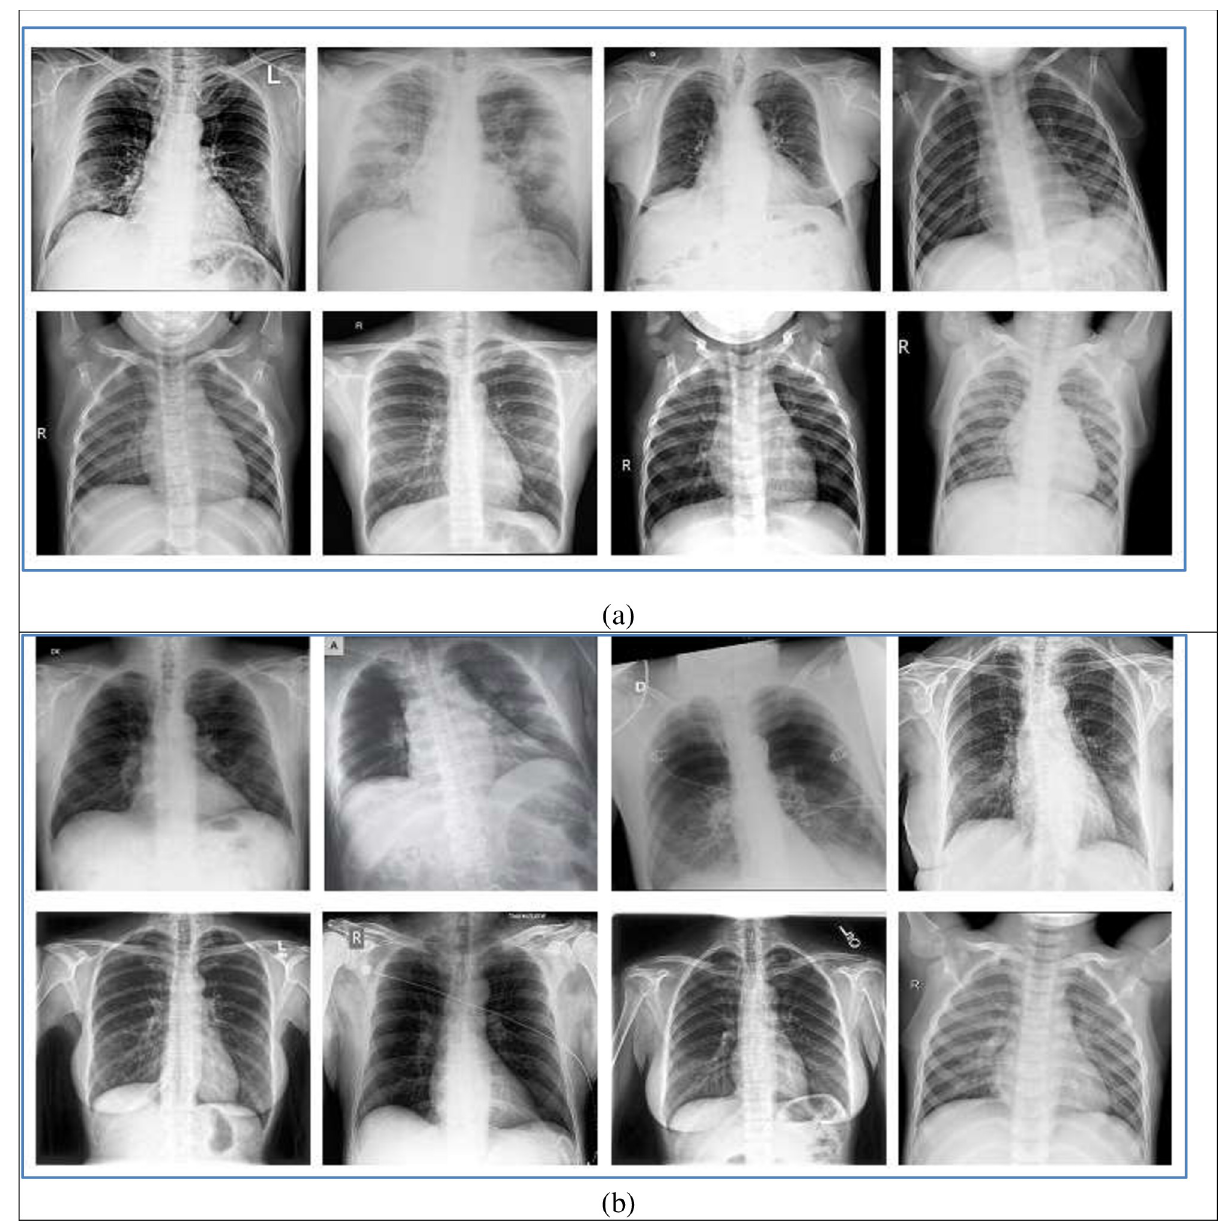
Fig 3. (A) Sample images of dataset-1 (B) Sample images of